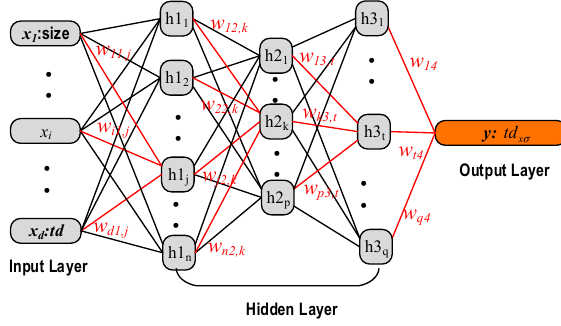
Figure 2. The architecture of the BP model. Table 2. Input and Output function of every layer.